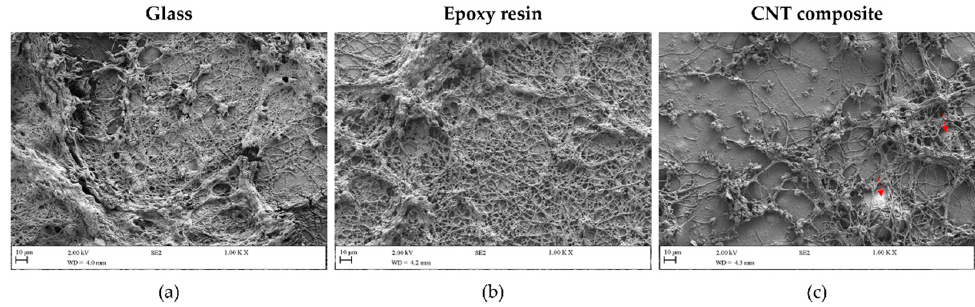
Figure 7. SEM images of Nodosilinea cf. nodulosa LEGE 10377 biofilms formed on glass ( a ), epoxy resin ( b ), and CNT composite ( c ) after 49 days of incubation. The red arrows in ( c ) indicate clusters of CNTs. Magnification = 1000×; scale bar = 10 μ m.